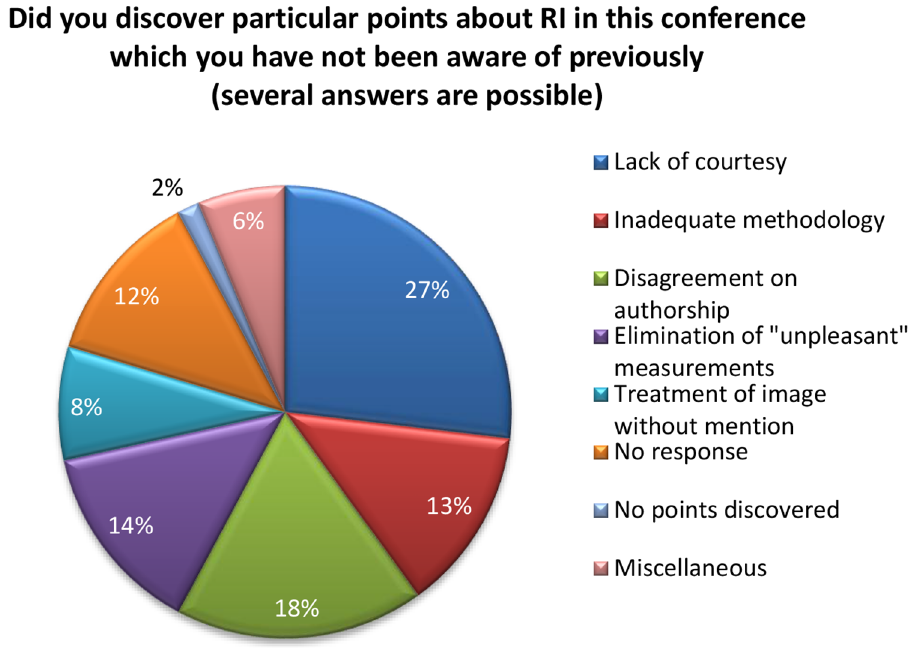
Fig. 3. Extended understanding of research integrity after the conference.